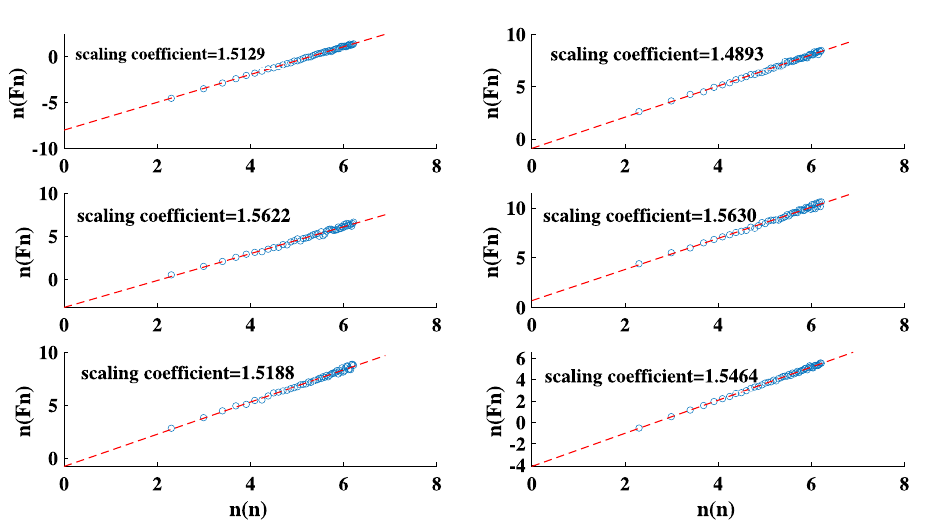
Figure 9. The scaling coefficient of the DFA for the exchange rate for euros to dollars (Euro/U.S. Dollar 1:1), gold price per ozt (Gold (ozt)/U.S. Dollar 1:1), Microsoft corp stock price, NASDAQ 100 index , S & P 500 index, U.S. dollar